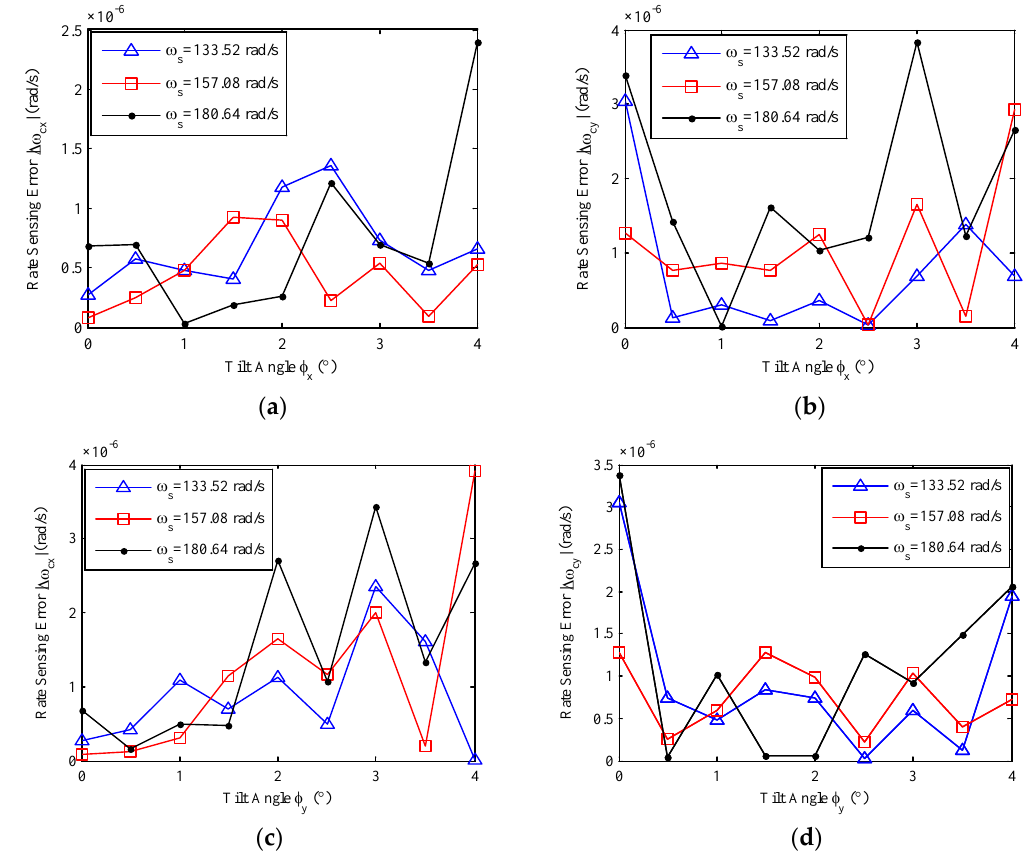
Figure 10. Relationship between rate sensing errors and tilt angles: ( a ) X -axis rate sensing error versus x -axis tilt; ( b ) Y -axis rate sensing error versus y -axis tilt; ( c ) X -axis rate sensing error versus y -axis tilt; ( d ) Y -axis rate sensing error versus x -axis tilt.